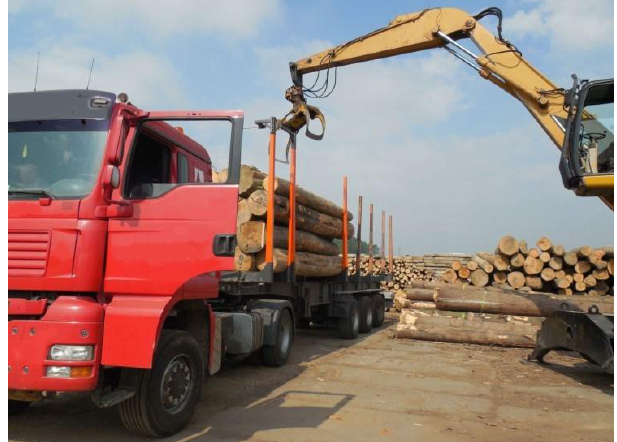
Figure 2. View of the truck during timber loading.